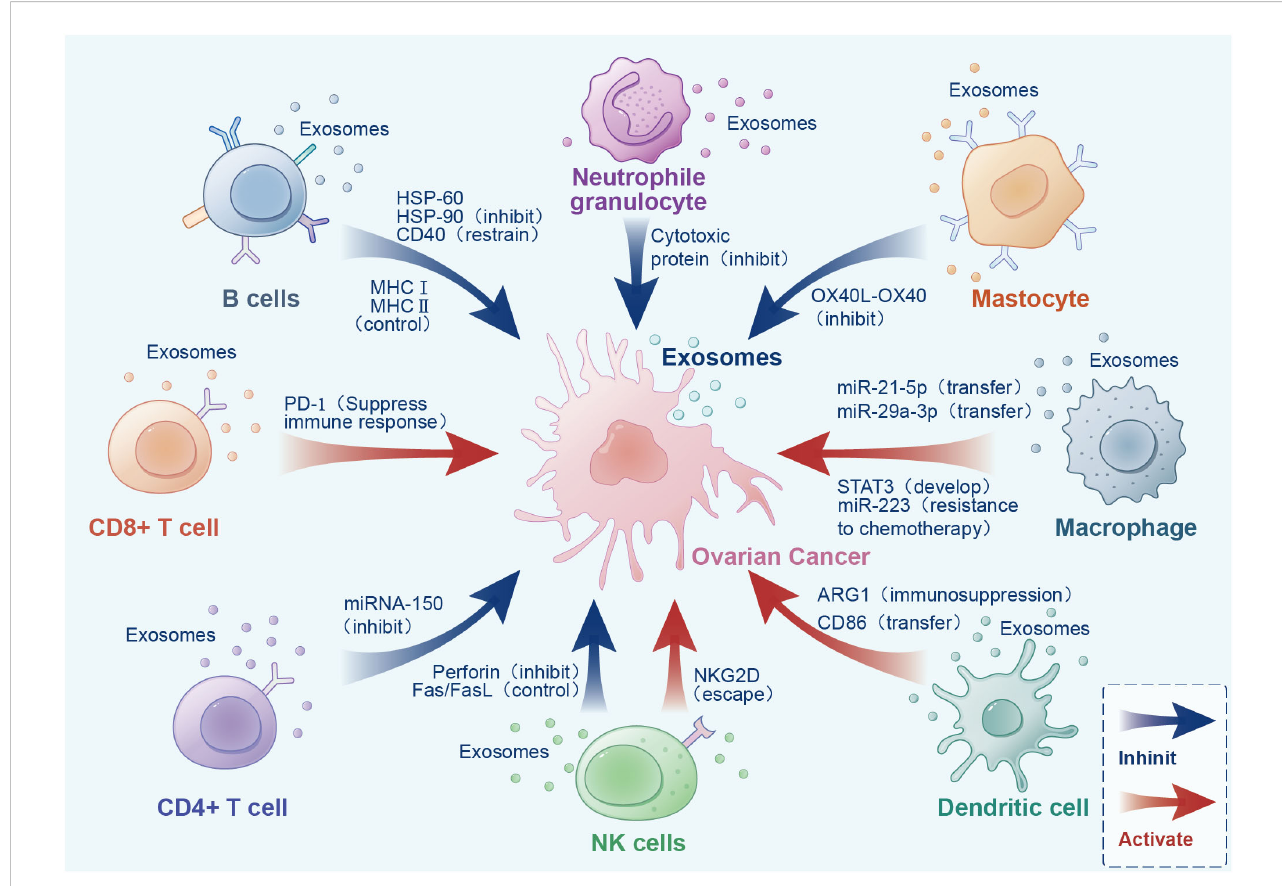
FIGURE 3 Bidirectional effects of exosomes from different sources in the tumor